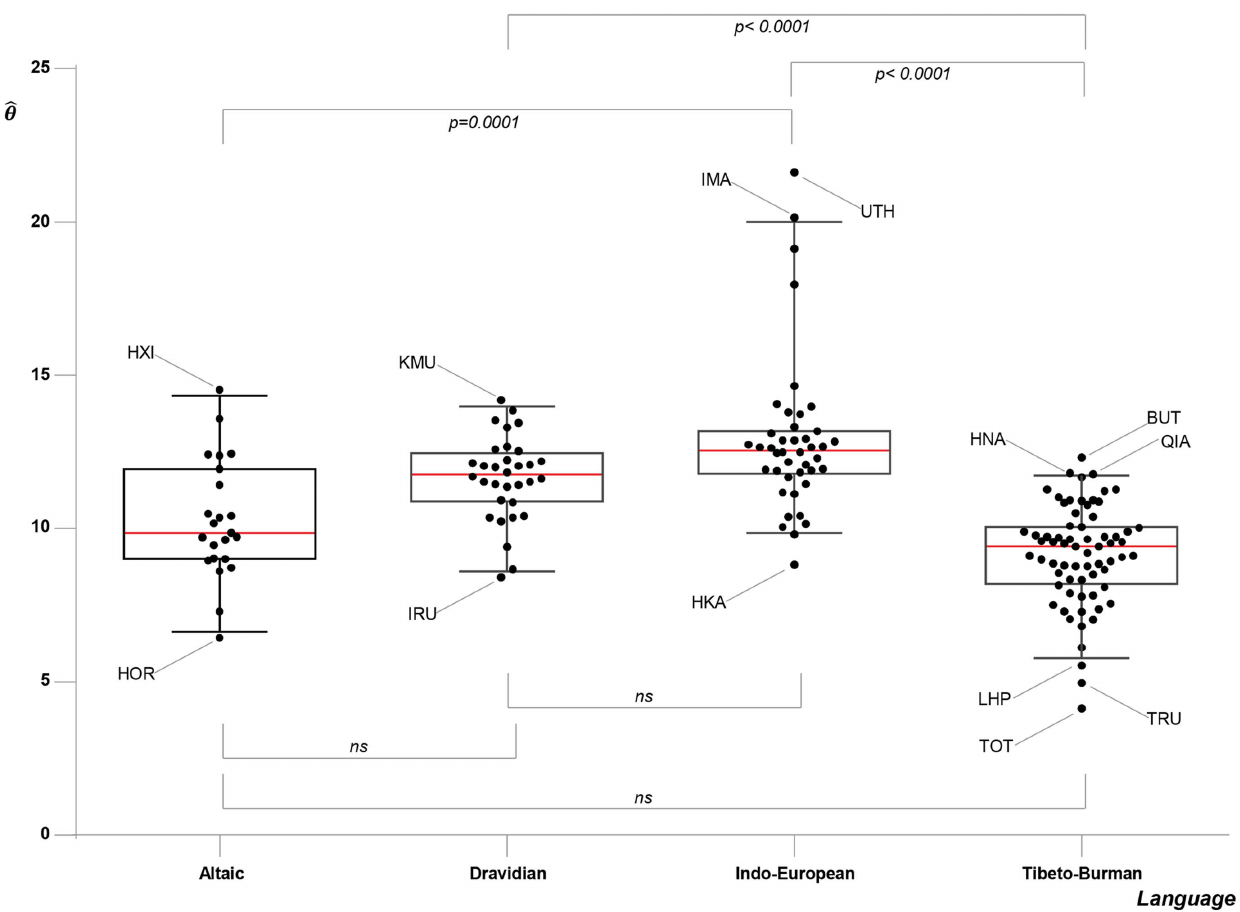
Figure 2. Results of significance tests for b hh values. b hh values are grouped by linguistic phylum with each dot representing one population. The median per phylum is indicated by a red line, the boxes surrounding the medians indicate the 25 th and 75 th percentiles and the 5 th and 95 th percentiles are indicated as error-bars. Non-significant results of the Kruskal-Wallis/Dunn’s multiple comparison test are indicated by lines with the text ns below the b hh values and significant results are indicated by lines with p-values above the b hh values. For the population abbreviations used in the figure, see tables 1 and S1.